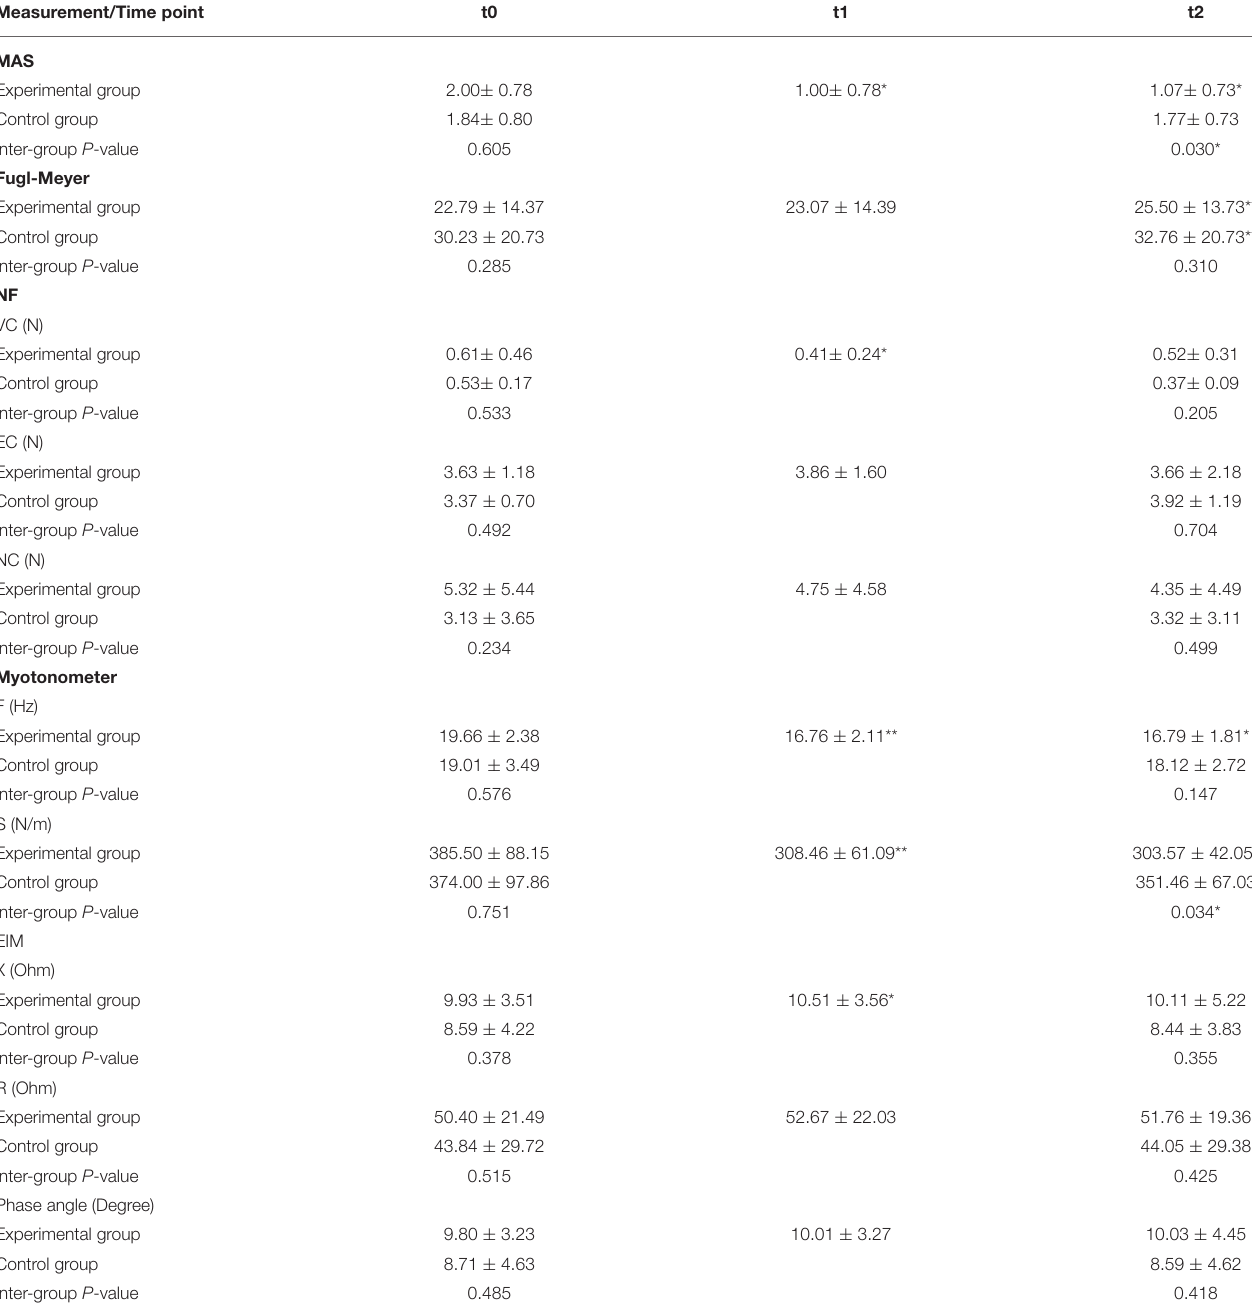
TABLE 3 | All outcome measures at each measuring time point. Measurement/Time